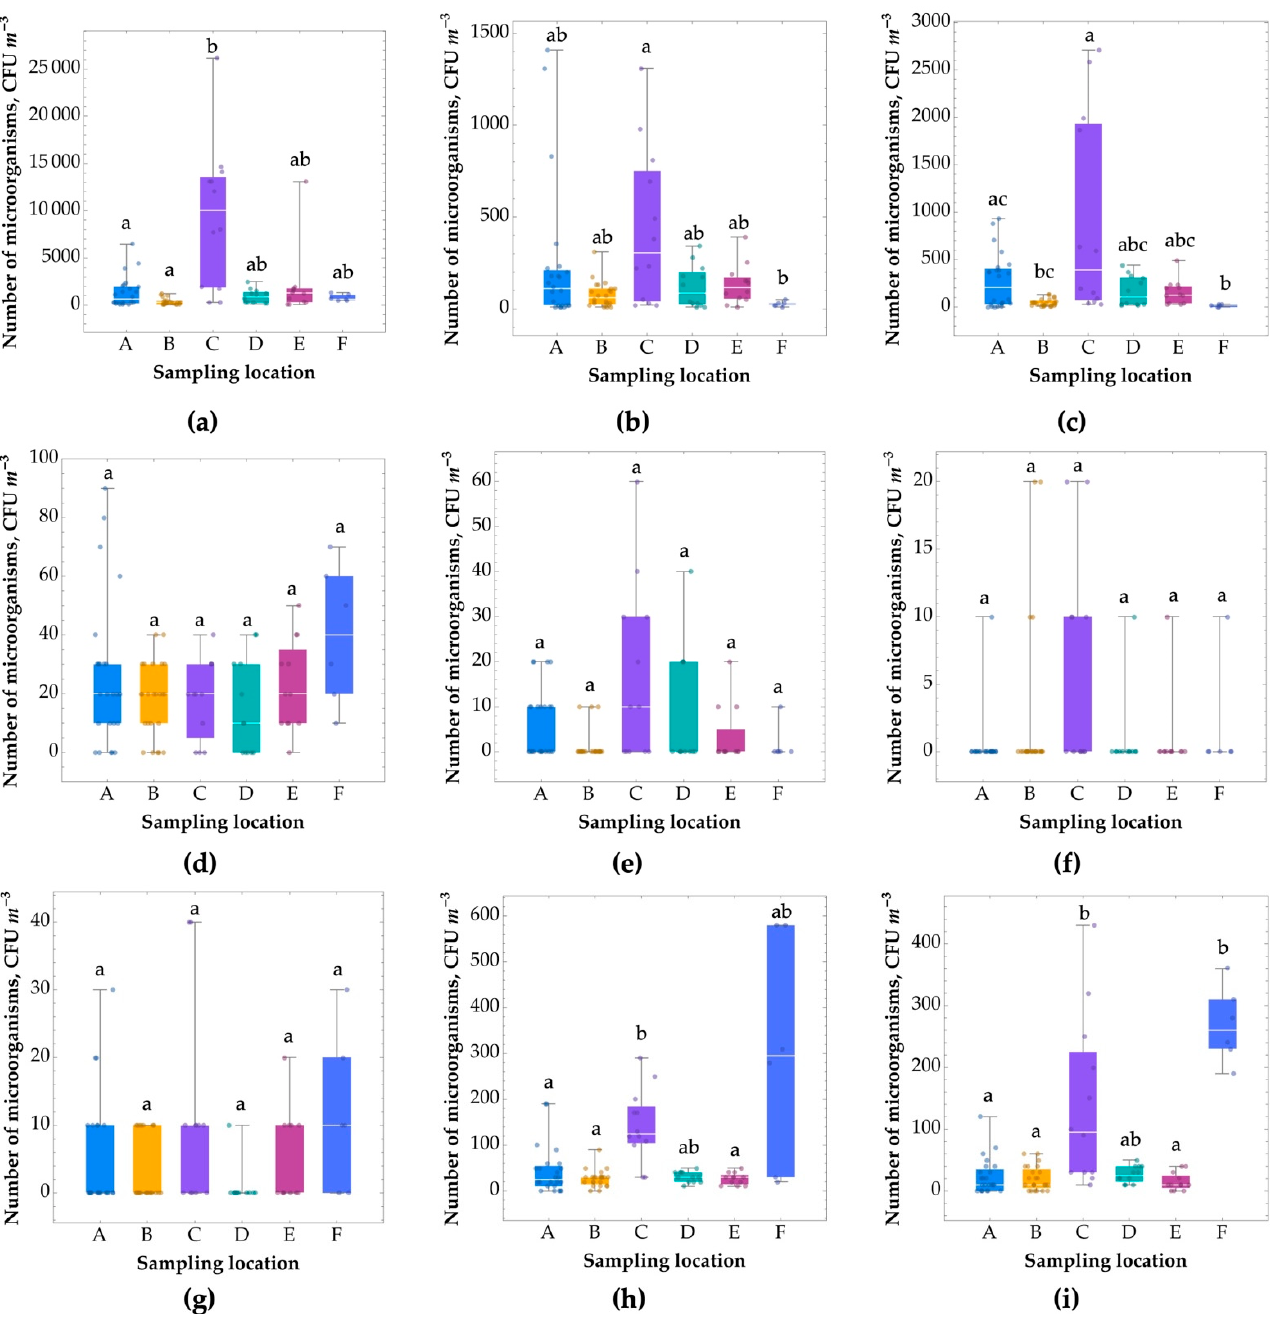
Figure 5. Boxplot showing the microorganism numbers at the selected locations; ( a ) bacteria, ( b ) Staphylococcus spp., ( c ) Staphylococcus aureus , ( d ) hemolizuj ą ce, ( e ) Enterobacteriaceae , ( f ) Pseudomo- nas fluorescens , ( g ) promieniowce, ( h ) fungi, ( i ) xerophilic fungi. The ends of the boxplot whiskers represent the minimum and maximum values of all the data. Results with different letters (a–c) are significantly different from each other (Kruskal − Wallis test followed by Dunn’s posthoc tests at a significance level of 0.05). (A) “climbing wall”; (B) “swimming pool”; (C) “changing room at the swimming pool”; (D) “basketball/volleyball court”; (E) “badminton court”; (F) “entrance to the building”.